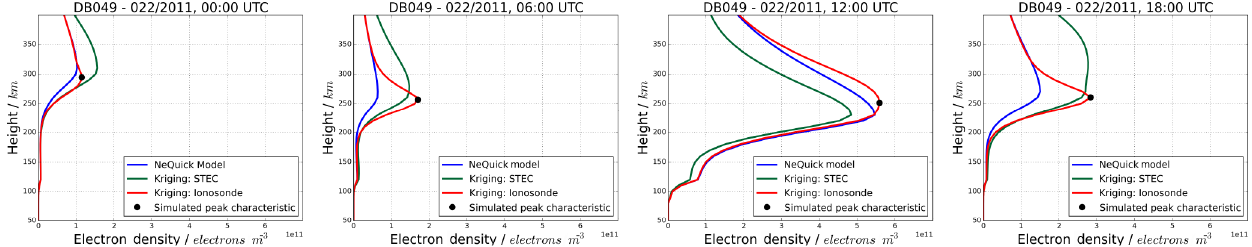
Figure 7. Simulation scenario: comparison of electron density profiles estimated by the NeQuick model (blue), the kriging with spatial covariance MI (green) and the GEK with spatial covariance MIII (red) assimilating only with F2 layer measurements at the ionosonde station location of DB049 on DOY